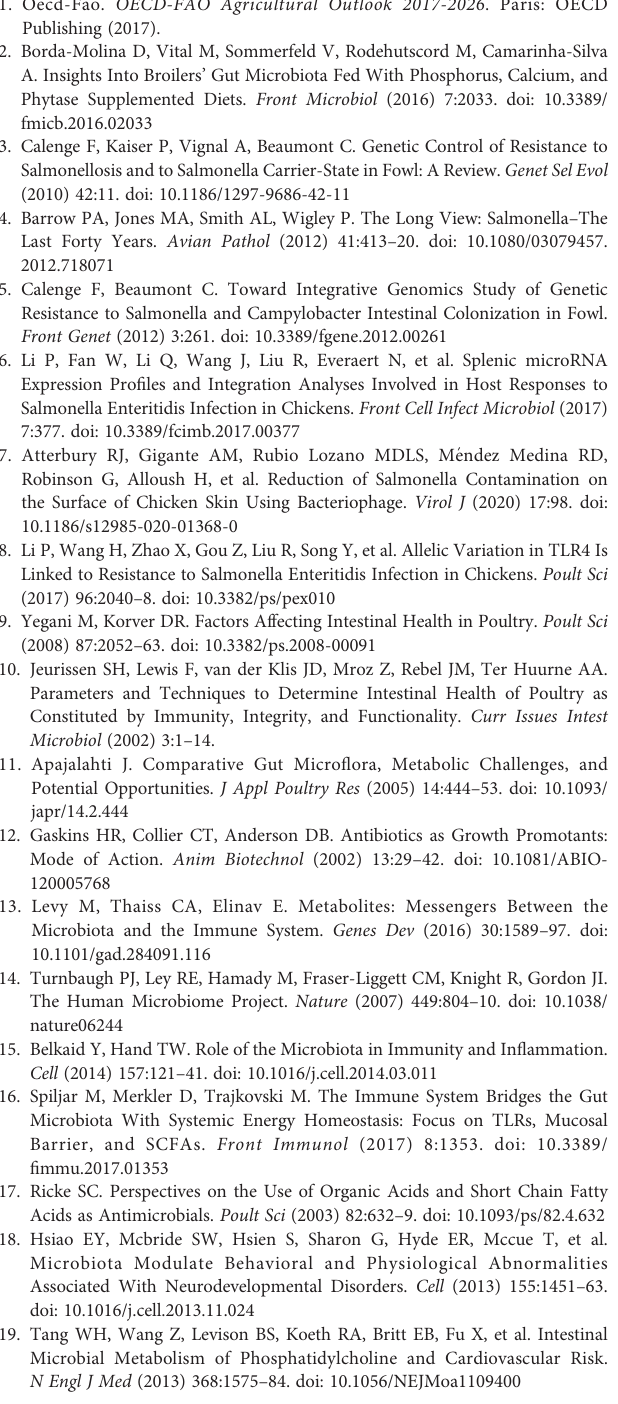
L ratio chickens infected by Salmonella at 7 and 21 dpi. (C) cecal microbiota genera and virulence factors contribution at the level 2. (D) cecal microbiota genera and virulence factors contribution. H7: High H/L SE-infected 7 dpi (n = 7); L7: Low H/L SE-infected 7 dpi (n = 6); H21: high H/L SE-infected 21 dpi (n = 6); L21: Low H/L SE-infected 21 dpi (n =